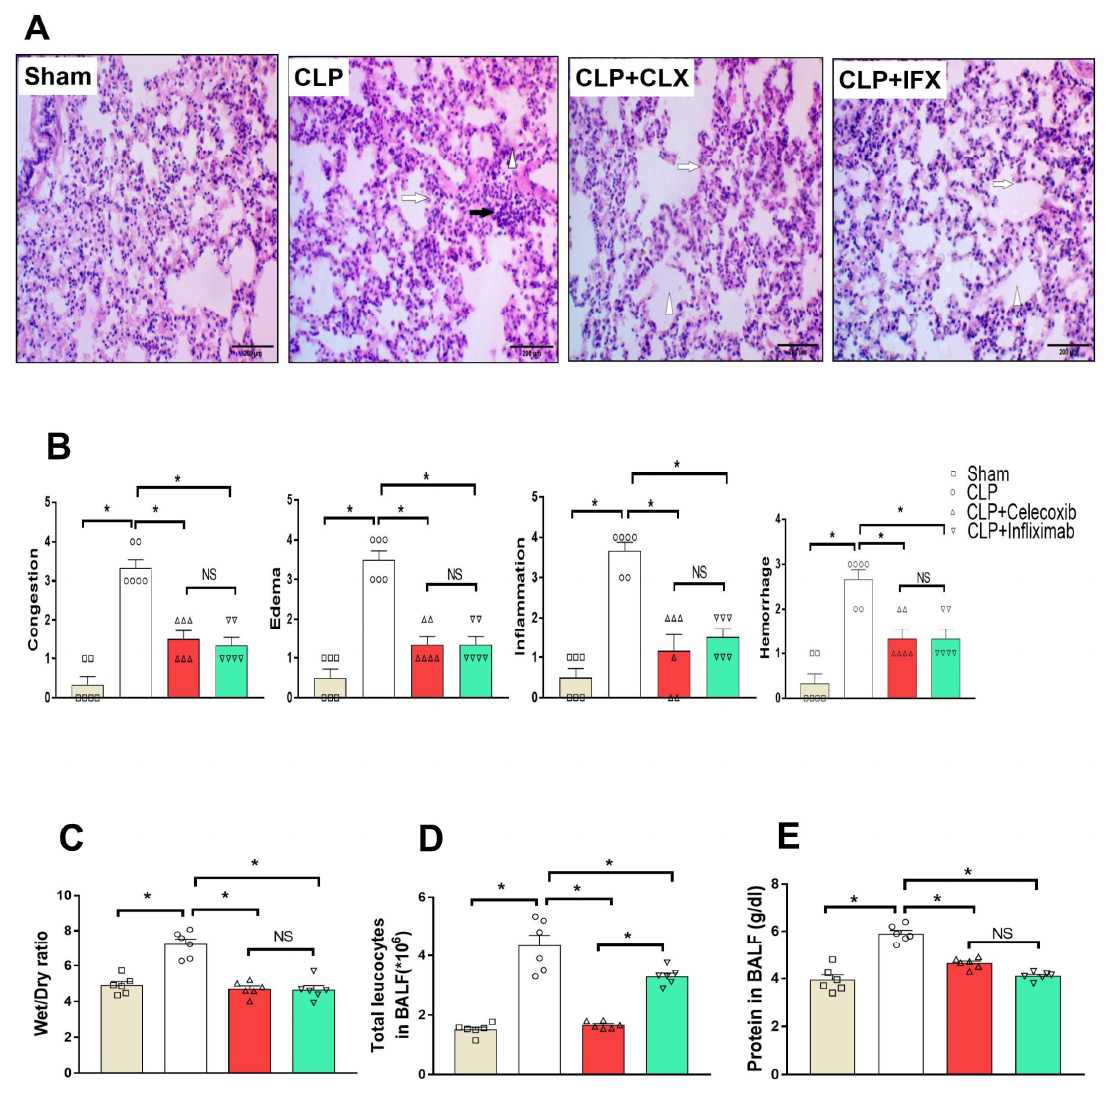
Figure 3. Effect of CLP and treatment with CLX and IFX against sepsis-induced ALI. ( A ) Photomi- crographs showing the effect of CLX and IFX administration on sepsis-induced histopathological lesions in rat lungs (H&E stain, 200 × ). The sham group revealed normal alveoli with intact alveolar membranes and alveolar spaces with intervening bronchioles. A thickened alveolar membrane in the CLP group was evident due to edema and inflammatory infiltrate (white arrow). Dilated and con- gested alveolar spaces with focal areas of alveolar membrane damage (arrowhead), interstitial tissue congestion, and areas of inflammatory infiltrates were formed mainly from alveolar macrophages and lymphocytes (black arrow). The CLP/CLX and CLP/IFX groups decreased such injuries following the induction of sepsis, which was apparent as multiple alveoli with intact alveolar membranes without rupture, inflammatory infiltrates (arrow), non-congested interstitial and empty alveolar spaces without hemorrhage or edema (arrowhead). ( B ) Analysis of lung injury score. ( C ) W/D weight ratio of lung tissue from different groups. ( D ) The total number of leukocytes in BALF from different groups. ( E ). Total protein content in BALF from different groups. Each bar represents the mean ± SEM; n = 6 for all groups. * denotes significant difference at p < 0.05.